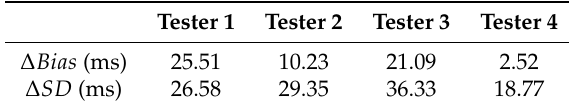
Table 5. Bland–Altman analysis on moving testers in Track 1.